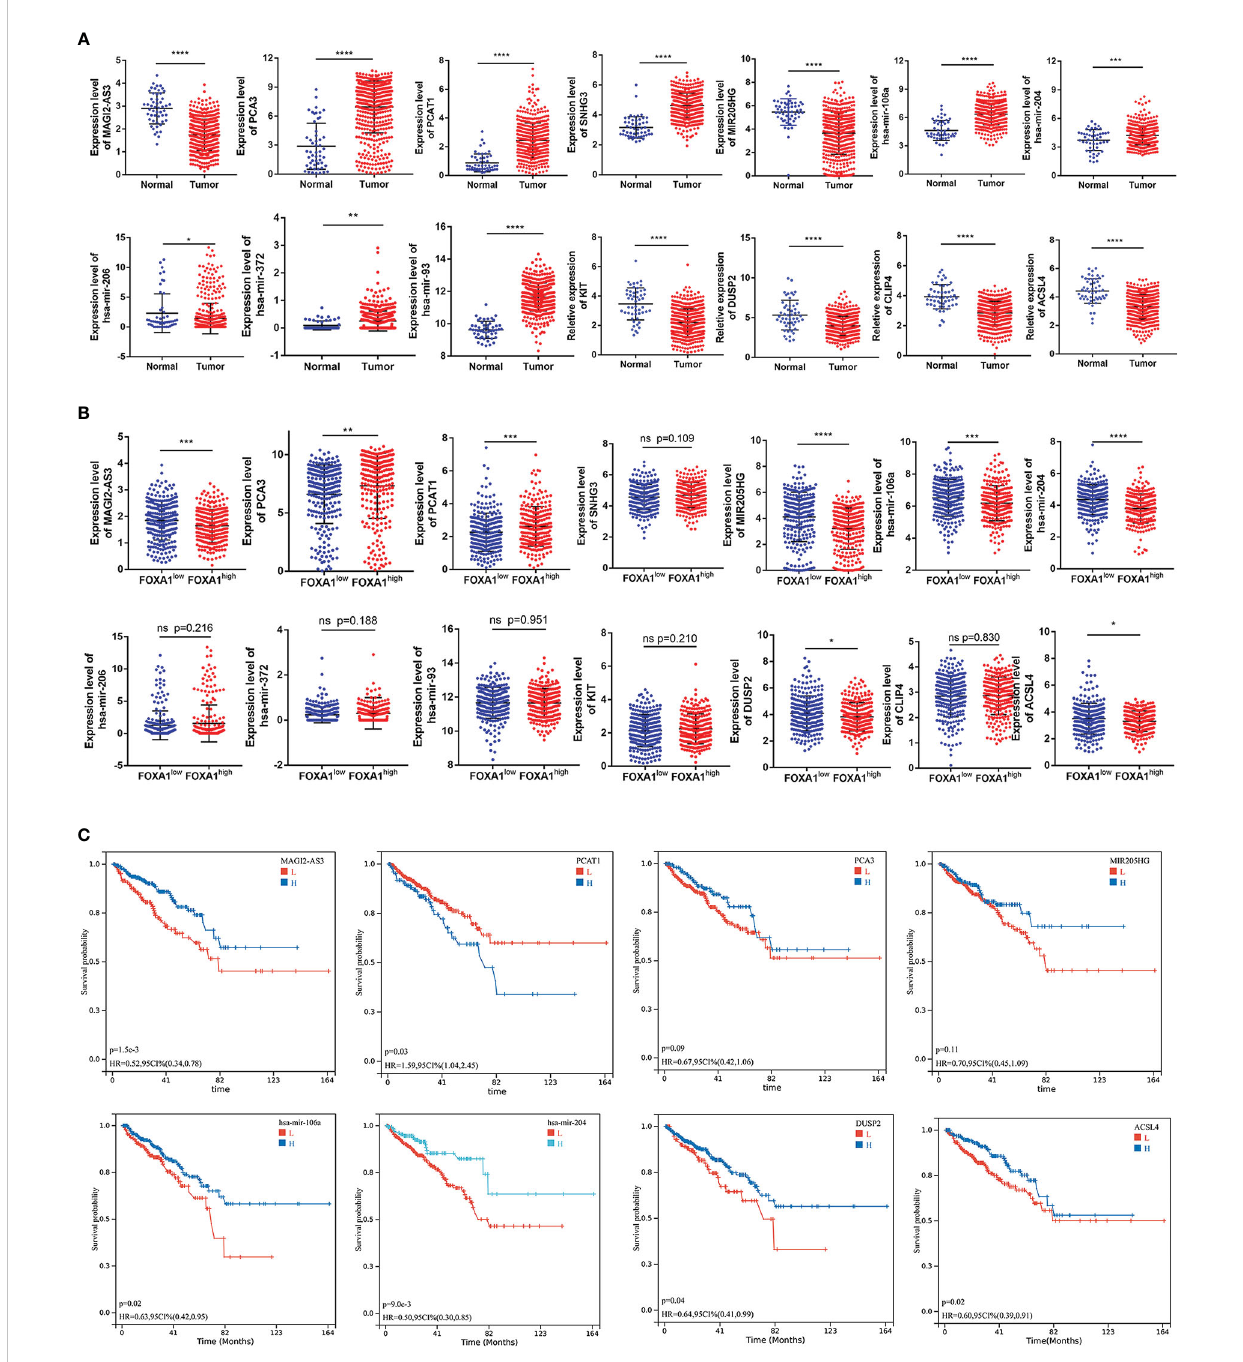
FIGURE 5 Expression and survival analysis for the hub genes. (A) The expression patterns of fi ve DElncRNAs, fi ve hub-DEmiRNAs, and four hub-DEmRNAs in PCa and adjacent normal prostate tissues and (B) in PCa samples with FOXA1 high and FOXA1 low expression groups. (C) The high- and low-expression values of hub genes were compared by a Kaplan – Meier survival curve for the TCGA prostate patient cohort. The horizontal axis indicates the overall survival time in months, and the vertical axis represents the survival rate. *P <0.05, **P < 0.01, ***P < 0.001,